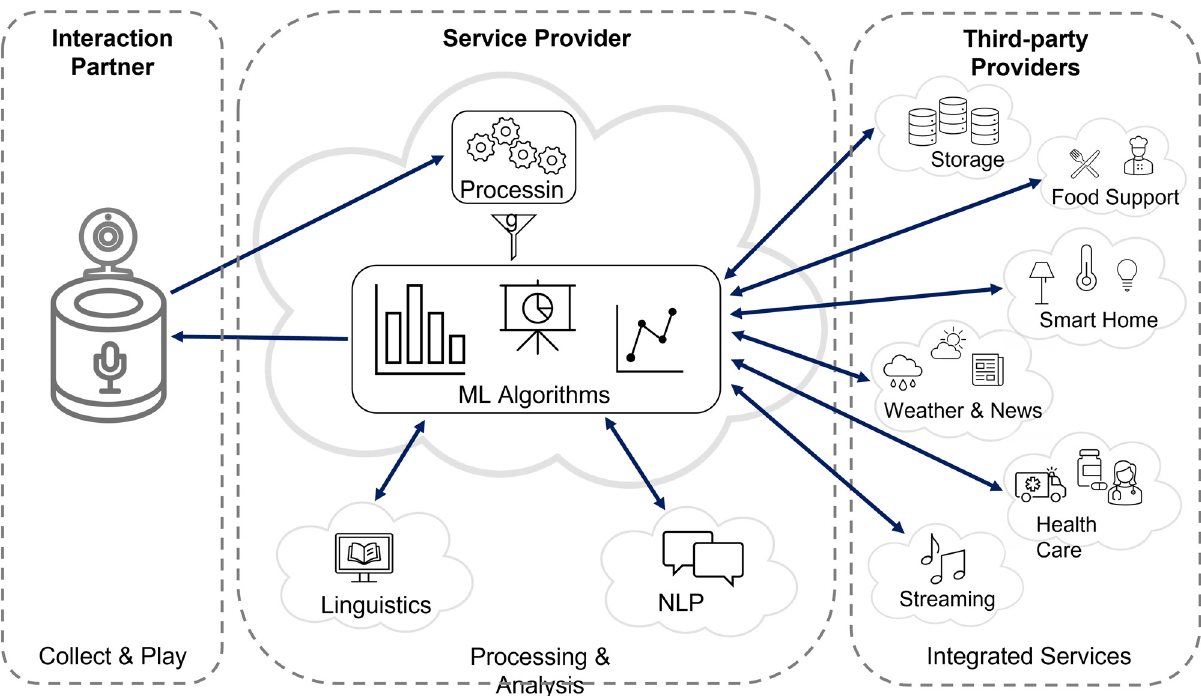
Figure 3: Interaction of service providers based on data processing and the fl ow of informations. ML, machine learning, NLP, natural language